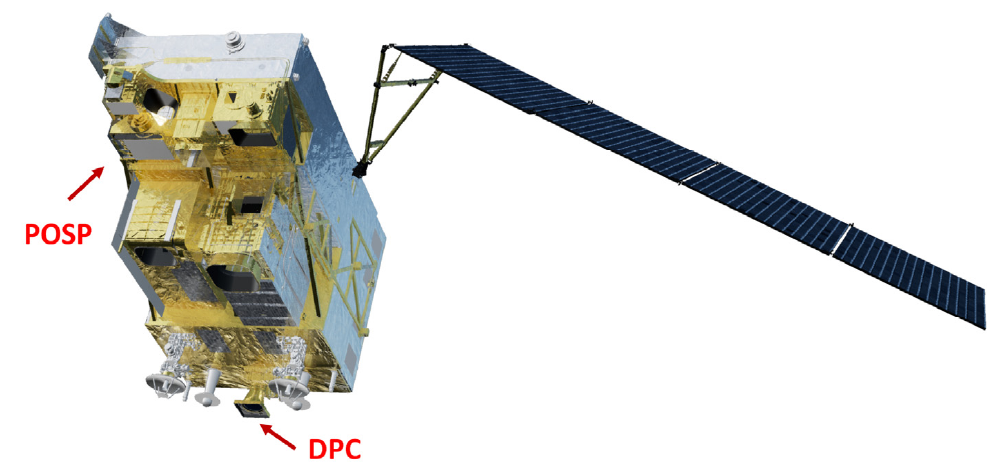
Figure 1. The sensor assembly of the PCF suite installed on the GaoFen-5(02) satellite. DPC is a polarimetric camera similar to the POLDER design concept. Its optical system consists mainly of an ultra-wide-angle lens, filters, and polarizers installed on the wheel. A charge-coupled device (CCD) is used as a detector for DPC, and its number of pixels is increased from 512 × 512 to 1024 × 1024 compared to DPC/GF-5 to achieve a better FOV match between DPC and POSP. Additionally, for one target region, it can be observed more than 15 times for different viewing angles by taking advantage of its wide FOV of ± 50 ◦ both in the along-track and cross-track directions. According to the 705 km satellite orbit altitude, the ground sampling distance (GSD) of a DPC pixel at nadir is about 1.7 km. After sinusoidal projection and pixel combination, the grid resolution of the DPC Level 1 product is about 3.5 km. Moreover, the preprocessing processes of DPC Level 1